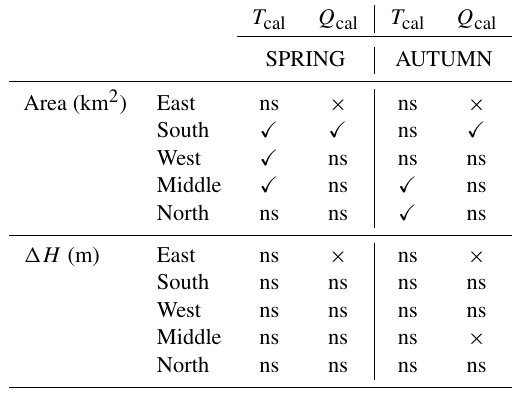
Table 1. Summary of significant correlations between CRPSS for calibrated temperature ( T cal ) and streamflow ( Q cal ) ensembles and catchment characteristics, i.e., area and elevation difference ( (cid:49)H ), for the five regions. “ (cid:88) ” indicates a significant positive relationship, “ × ” a significant negative relationship, and “ns” a non-significant relationship. Results are for a lead time of 5